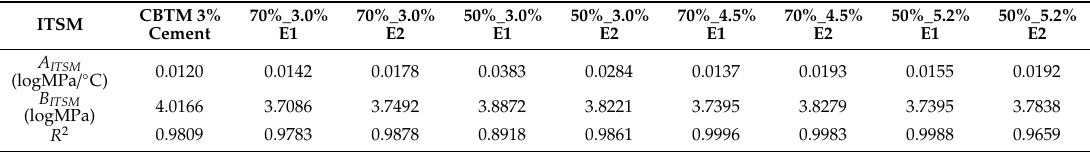
Table 2. Fitting parameters for the ITSM temperature dependency, calculated in Equation (1).